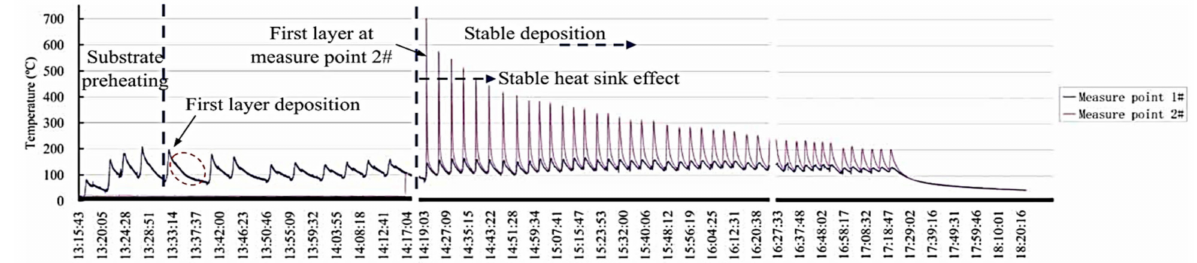
Figure 30. Measured temperature curve. Reprinted with permission from Ref. [73]. Copyright 2017 Taylor &Francis Ltd.